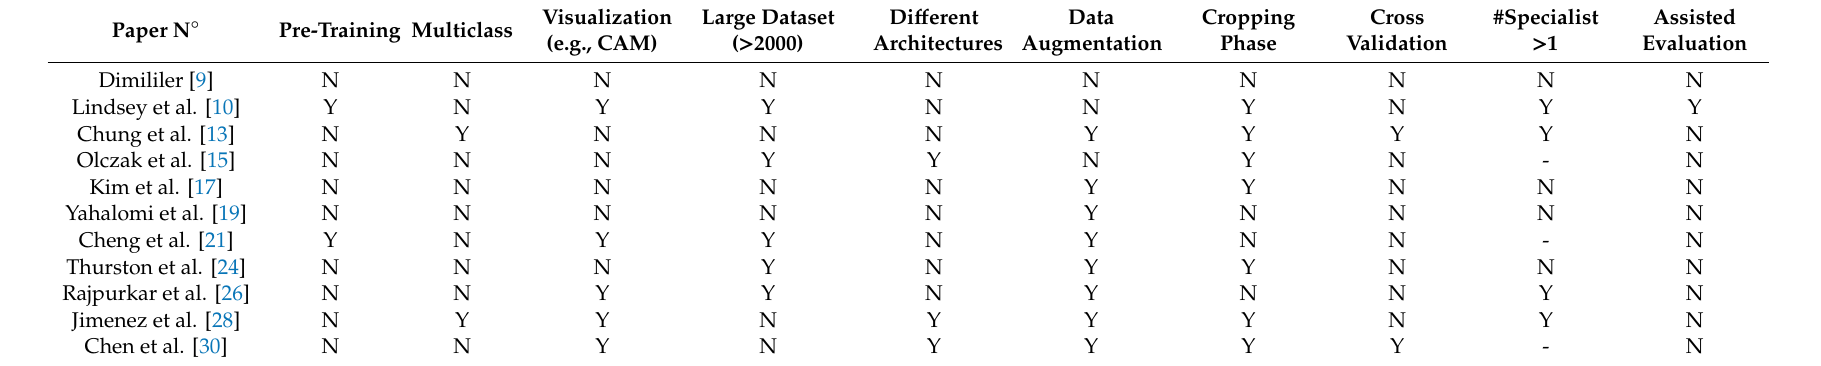
Table 3. Comparison between our proposed baseline and each